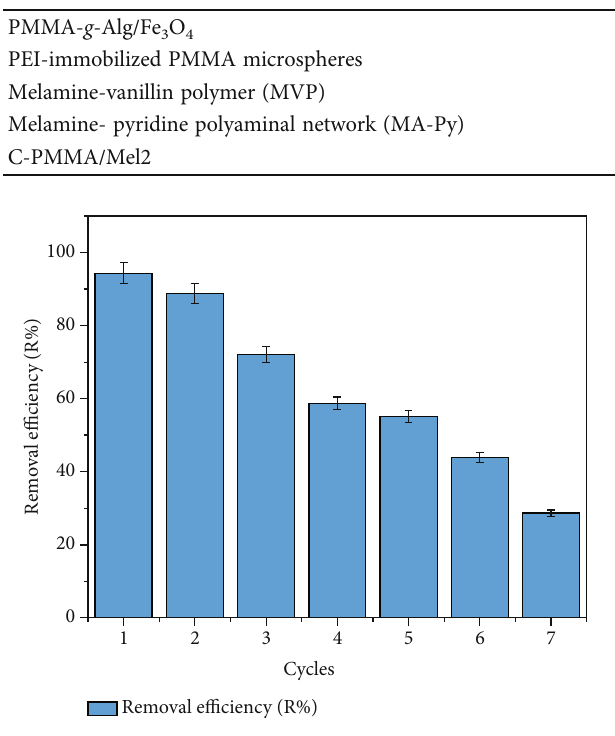
Figure 9: Adsorption – desorption recycles of Pb(II) ( m = 20 mg , V = 100mL , pH = 6 , and initialconcentrationof Pb ð II Þ = 20 mg/L